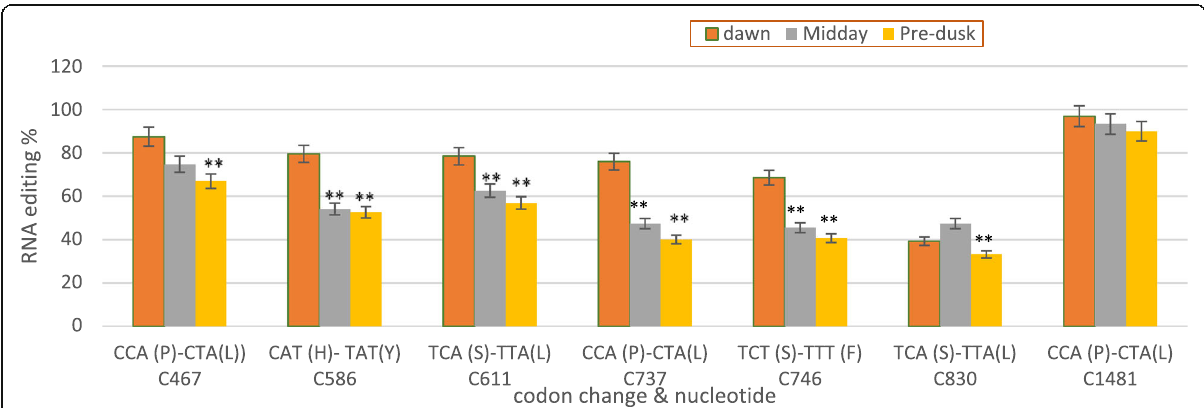
Fig. 3 Differential and efficiency of nad RNA editing, comparing with dawn, using reads derived from total RNA-seq. (P) Proline, (L) Leucine, (H) Histidine, (Y) Tyrosine, (S) Serine, (F) Phenylalanine. Data are expressed as means with ±SD (black bars) of three biological replicates. ** indicate significant difference between treatments P < 0.01.